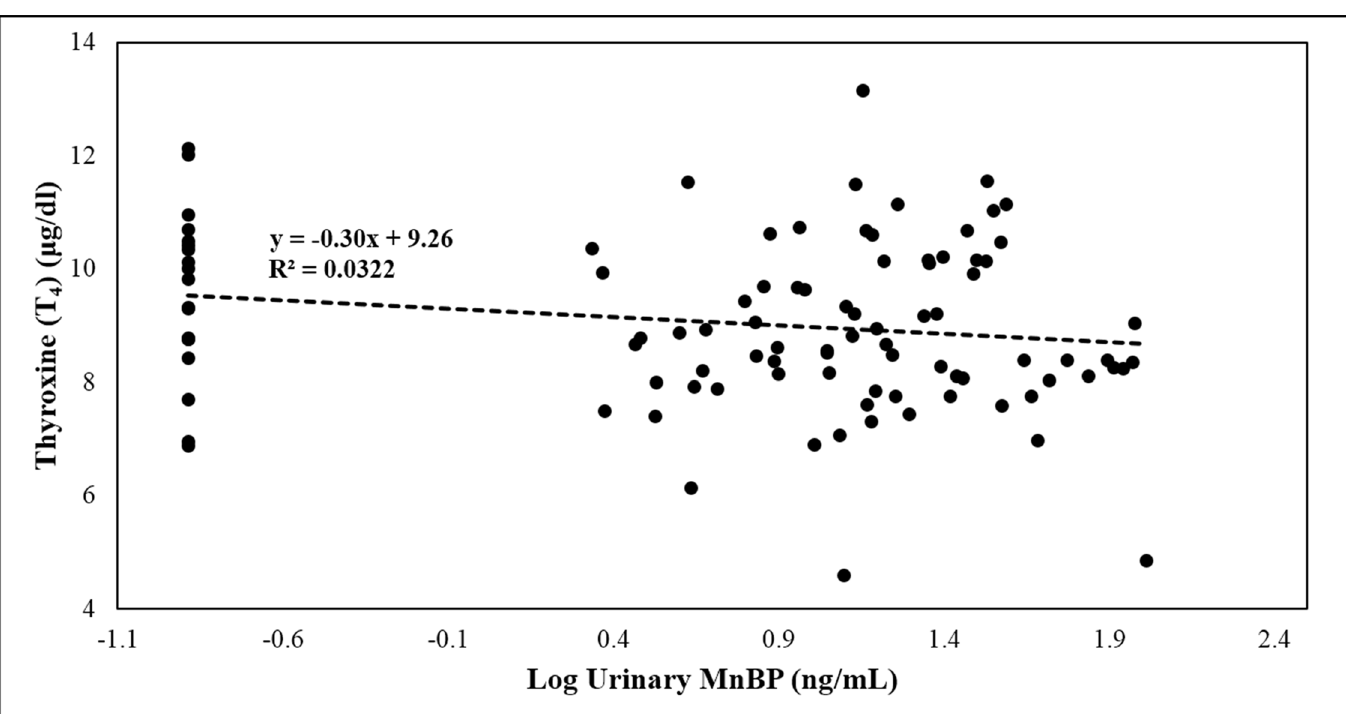
Fig 3. Scatter plot of correlation between serum thyroxin and urinary MnBP in pregnant women at first trimester (N = 97).